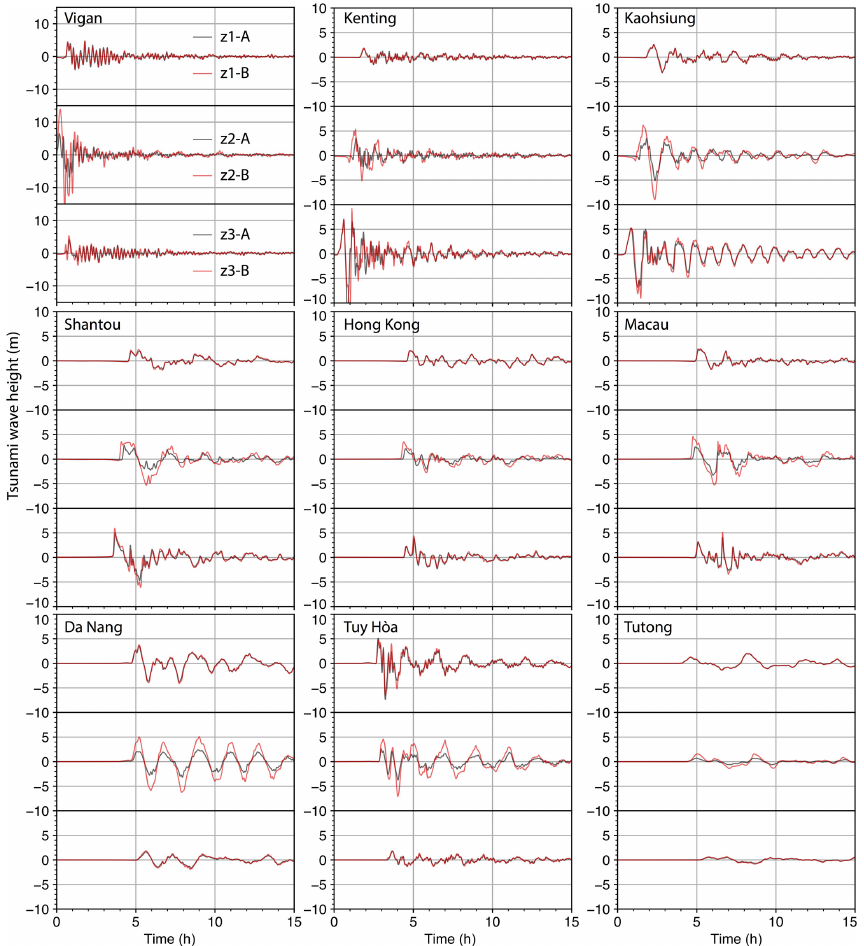
Figure 9. Simulated tsunami wave time histories at example coastal cities in the SCS region. Top, middle, and bottom of each subpanel show simulated waves from ruptures in zones 1–3, respectively. A and B represent coupling models A and B from Hsu et al. (2016). For rupture zone 3, we show the Gaussian slip distribution with 50% coupling ratio cases (Fig. 3c and f) as